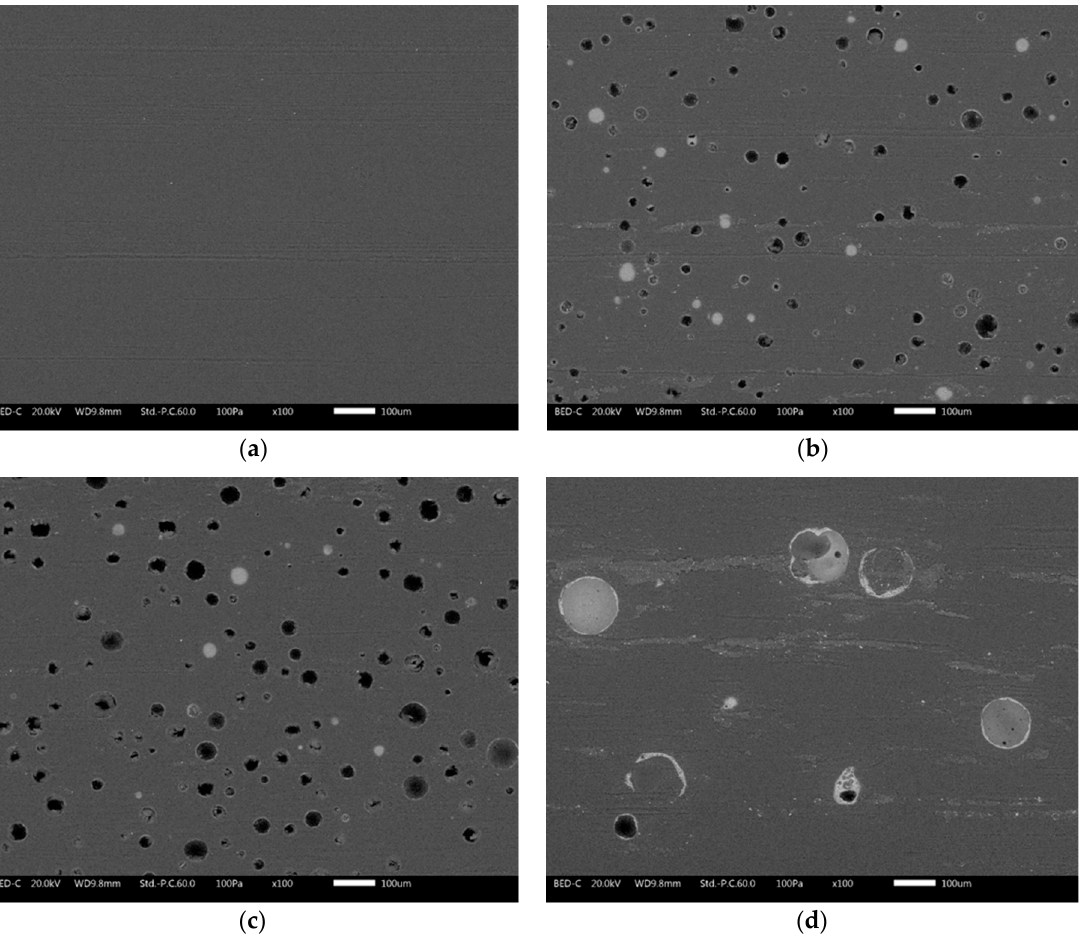
Figure 7. SEM micrographs of the surface morphology of ( a ) sample G0, ( b ) sample G1, ( c ) sample G2 and ( d ) sample G3 after the 1000 scrub test cycles (scale bar: 100 µm).